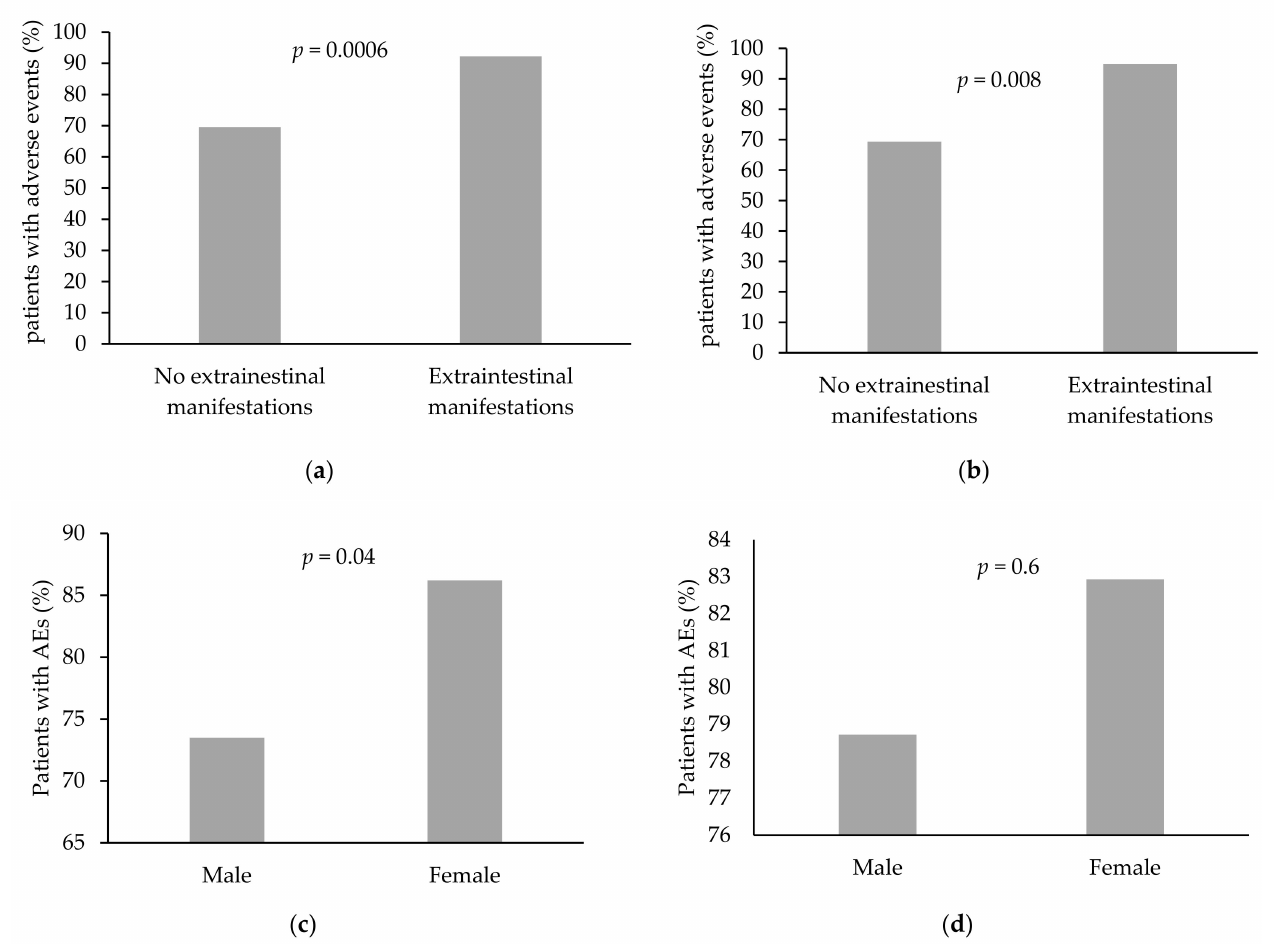
Figure 3. Association of extraintestinal manifestations and gender with the reporting of adverse events (AEs). ( a ) Percentage of AE among infliximab-treated patients with and without extraintestinal manifestations ( p = 0.0006, OR 5.1, CI 2.0–13.3). ( b ) Rate of AE among vedolizumab-treated patients with and without extraintestinal manifestations ( p = 0.008, OR 8.1, CI 1.7–38.3). ( c ) Percentage of AEs among male versus female patients treated with infliximab ( p = 0.04, OR 2.2, CI 1.0–4.9). ( d ) Percentage of AEs among male versus female patients treated vedolizumab ( p = 0.6, OR 1.3, CI 0.4–3.8). Abbreviation: AEs = adverse